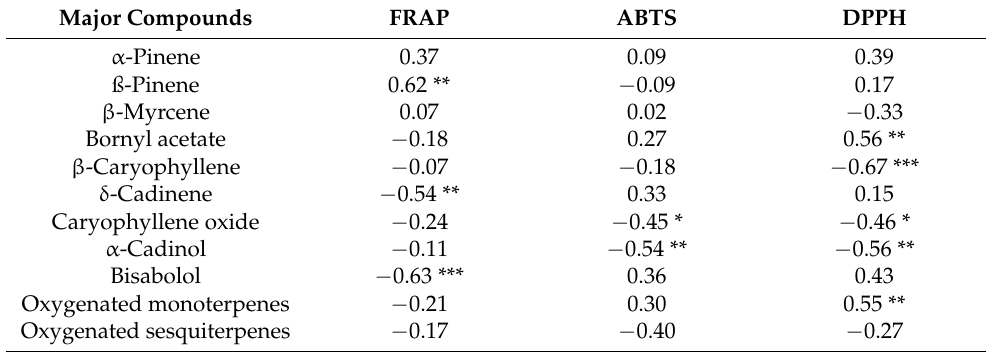
Bisabolol − 0.63 *** Oxygenated monoterpenes − 0.21 Oxygenated sesquiterpenes −